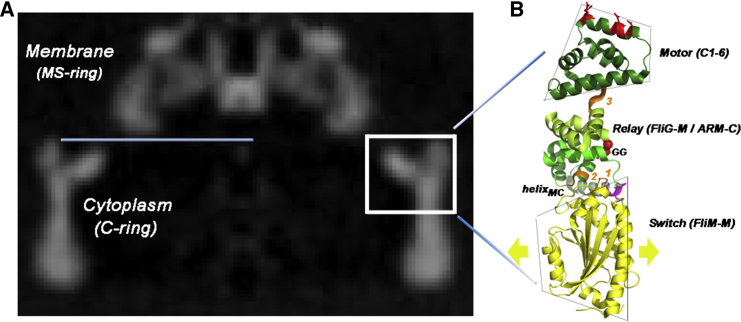
The Salmonella Basal Body MSC Ring and the T. maritima Proximal Switch Complex(A) A cross-section through the Salmonella flagellar basal body electron microscopy reconstruction (Thomas et al., 2006) showing transmembrane MS ring and the cytoplasmic C ring. Blue line marks membrane cytoplasm boundary. Box marks the surmised location of FliG and associated FliMM. The FliG ring interacts with transmembrane Mot stator complexes. FliMM reports CheY binding to FliG and adjacent FliM subunits (gold arrows).(B) The atomic structure (PDB: 4FHR) of the T. maritima complex: FliMM (gold), FliGM (green), FliGc ARM-C (olive), C1-6 (dark green), MFVF motif (orange), and TH (red side chains). Deletion of three Salmonella residues homologous to T. maritima PEV (magenta) produces a CW biased phenotype. See also Figure S1 for secondary structures and the contact interface.